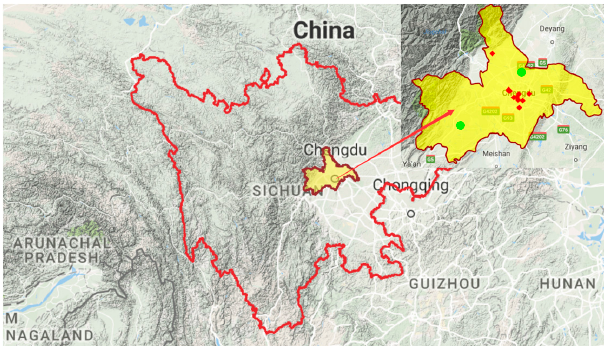
Figure 2. Terrain map of Sichuan Province (the area in yellow is Chengdu, our study area. Red points indicate the air pollution monitoring stations and green points are the meteorological observation stations).